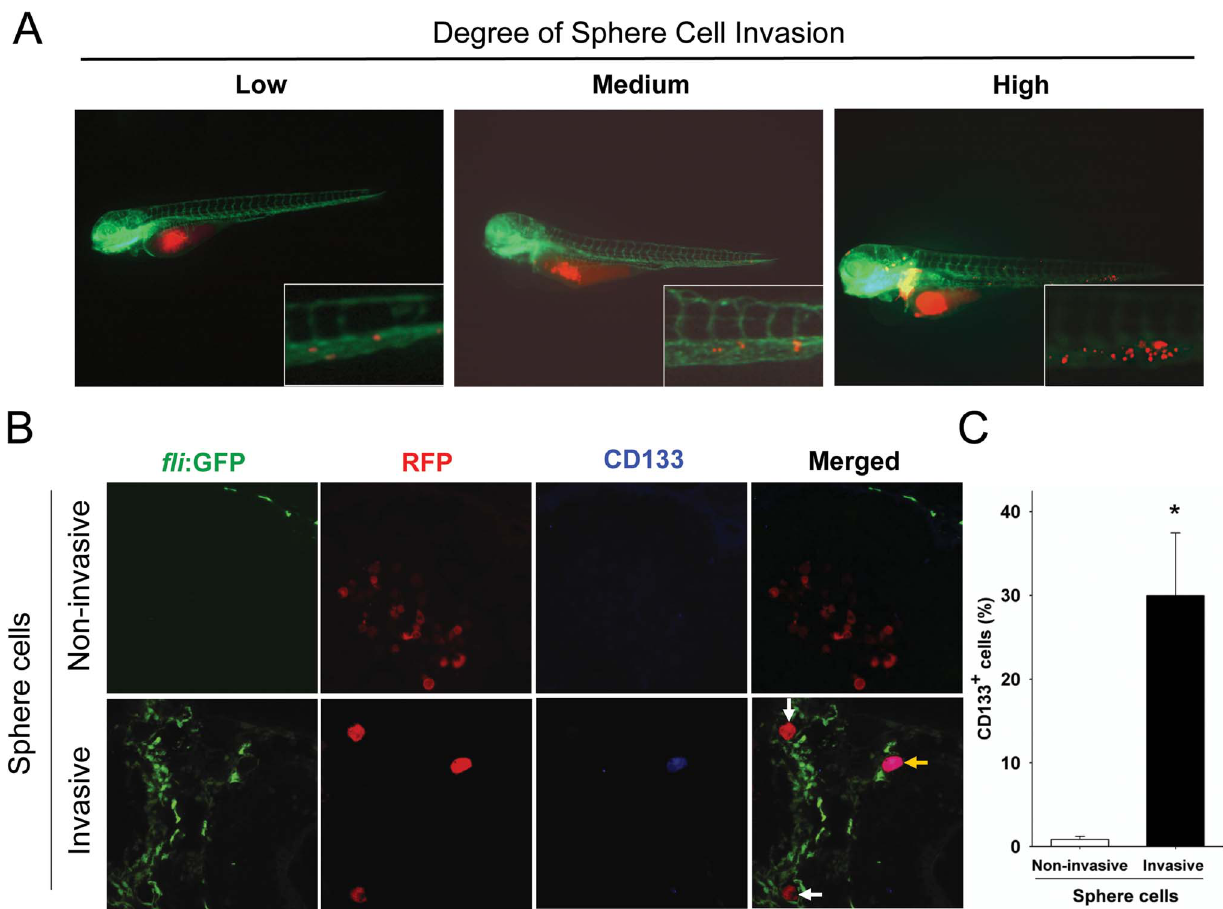
Figure 2. Invasive U87 sphere cells express CD133. A. U87 sphere cells with various invasion capability within zebrafish embryos. The extent of invasion was classified in three degrees: Low: less than 5 migrated cells; Medium: 5–20 migrated cells; High: more than 20 migrated cells. Representative images at higher magnification show the invasive RFP-labeled U87 sphere cell masses (red) in the tail region of the embryos via EGFP- labeled host vessels (green). B. Detection of CD133 expression on non-invasive and invasive U87 sphere cells at 2 dpi by immunofluorecent staining. All of U87 sphere cells within injected embryos were stained with monoclonal anti-CD133 antibody (1:300) and examined by confocal microscopy. Green: Tg ( fli1 :EGFP) y1 microvessels; red: RFP-labeled U87 sphere cells; blue: CD133 positive U87 cells. C. Quantitative analysis of CD133-expressing cells in non-invasive cell group (n=713) and high-invasive cell group (n=175) at 2 dpi. ( p , 0.001).